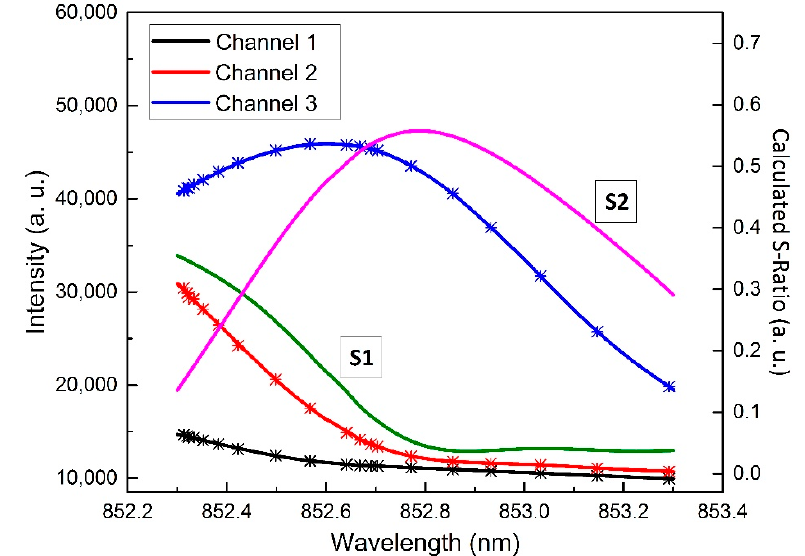
Figure 3. Correlation between center wavelength of the light portion reflected at the fiber Bragg grating (FBG) and the averaged intensities of the CMOS pixels at the AWG output waveguide positions. By using the fitted values as inputs for Equation (1), the green S-ratio course was calculated for channel 1 and 2 and the magenta S-ratio course was calculated for channel 2 and 3, respectively.